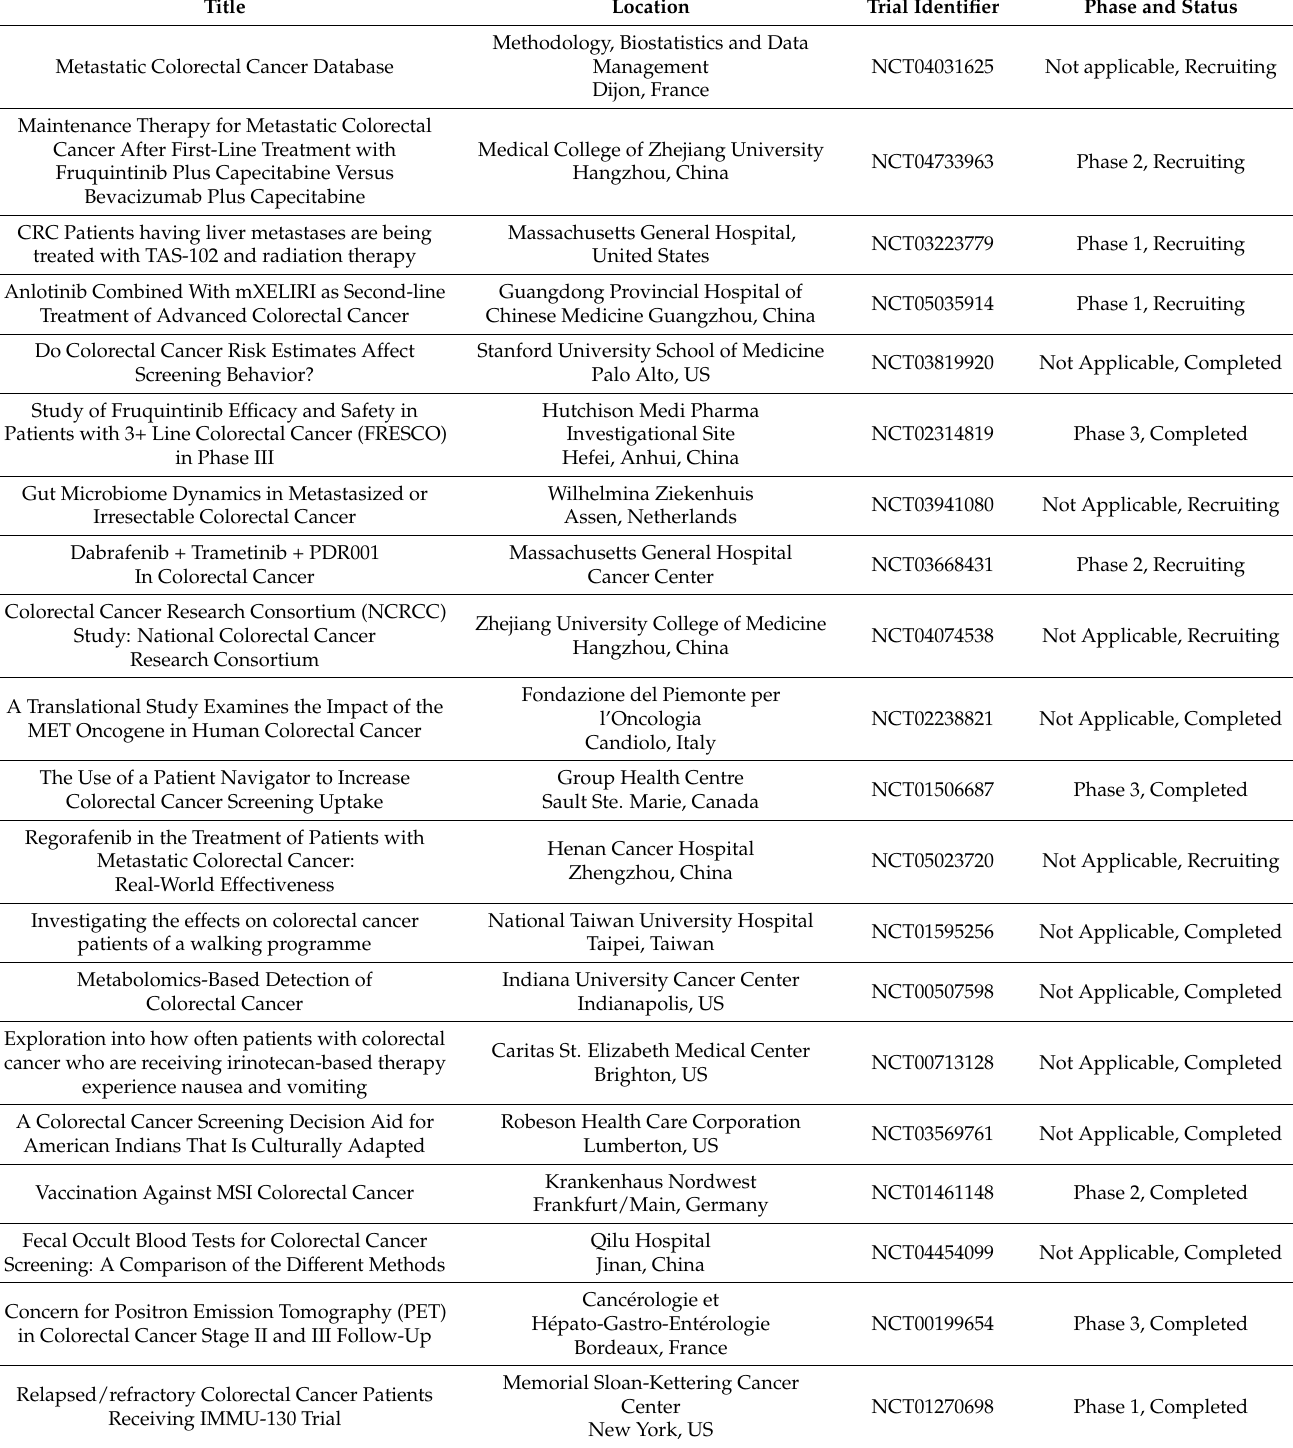
Table 2. Illustration of completed and ongoing clinical trials evidence for